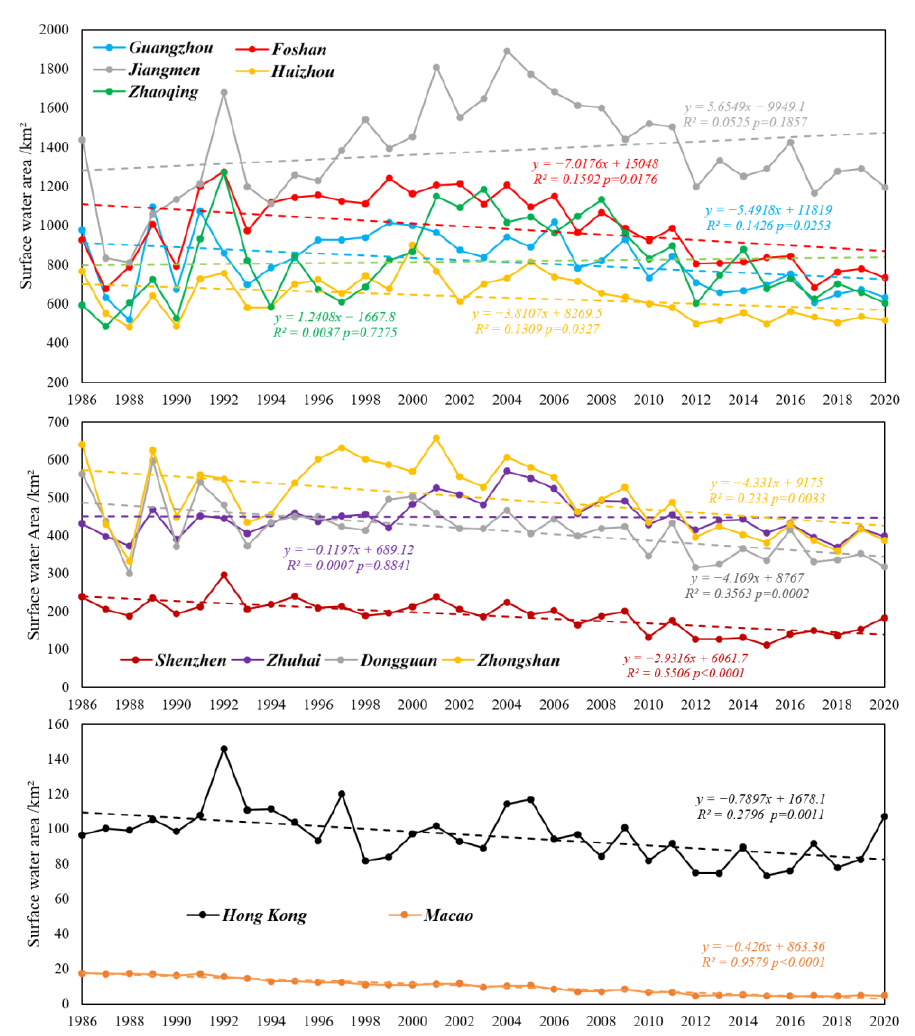
Figure 8. The temporal change and linear trend regression of surface water area for 11 cities in the GBA.